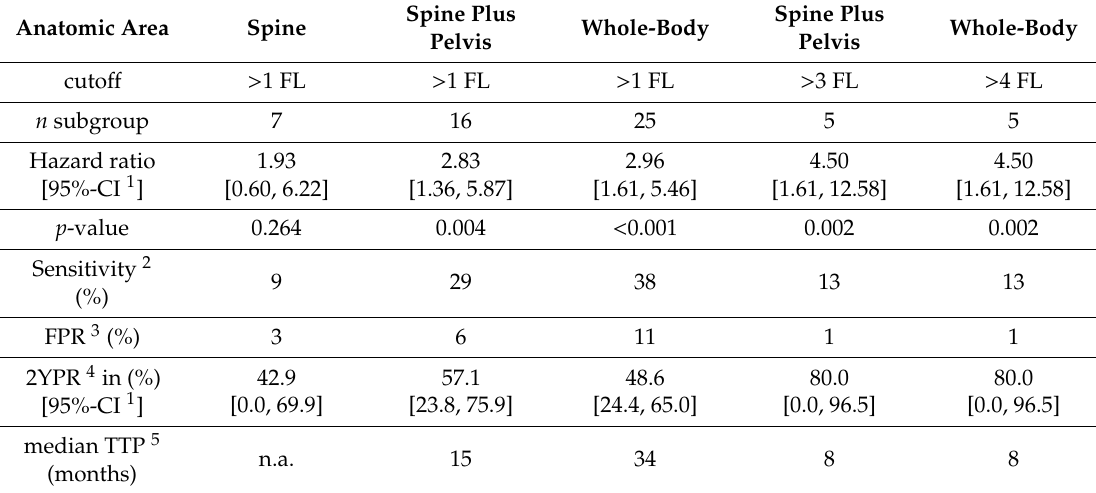
Table 4. Risk for development of CRAB-criteria in patient subgroups selected by a specific number of FL in the respective anatomic